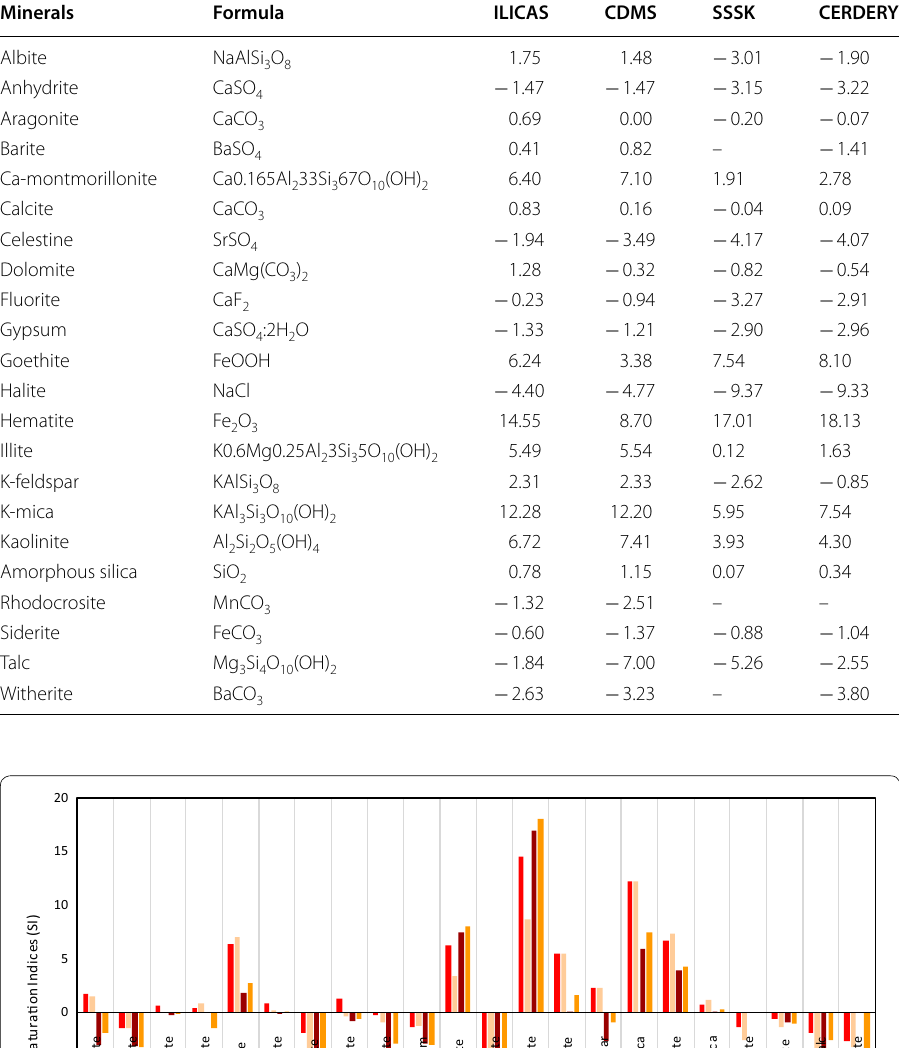
Table 4 Mineral saturation indices (SI) for thermal waters in the Şavşat Geothermal Field Minerals